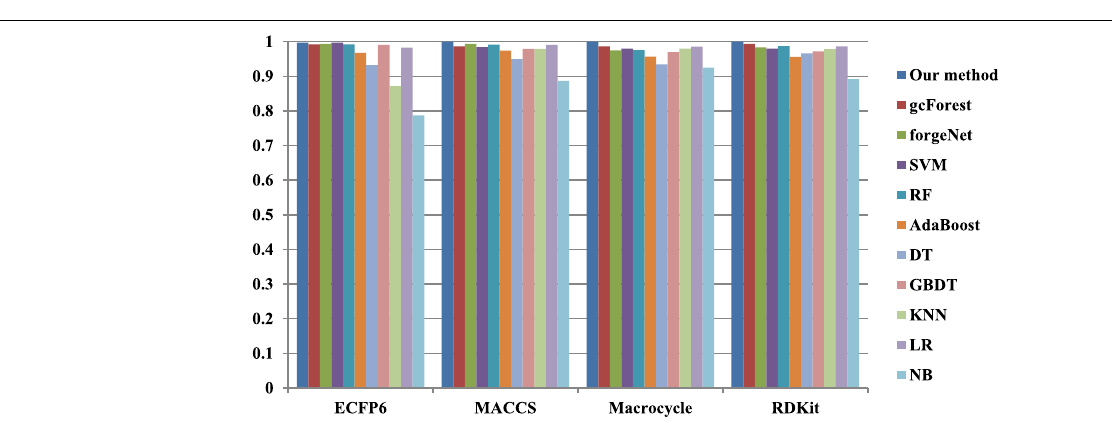
FIGURE 6 | AUC performances of 11 methods with COVID-19